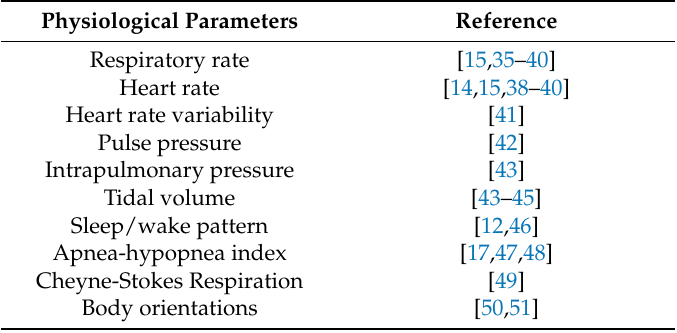
Table 1. Feasible parameters that can be estimated using non-contact Doppler radar.